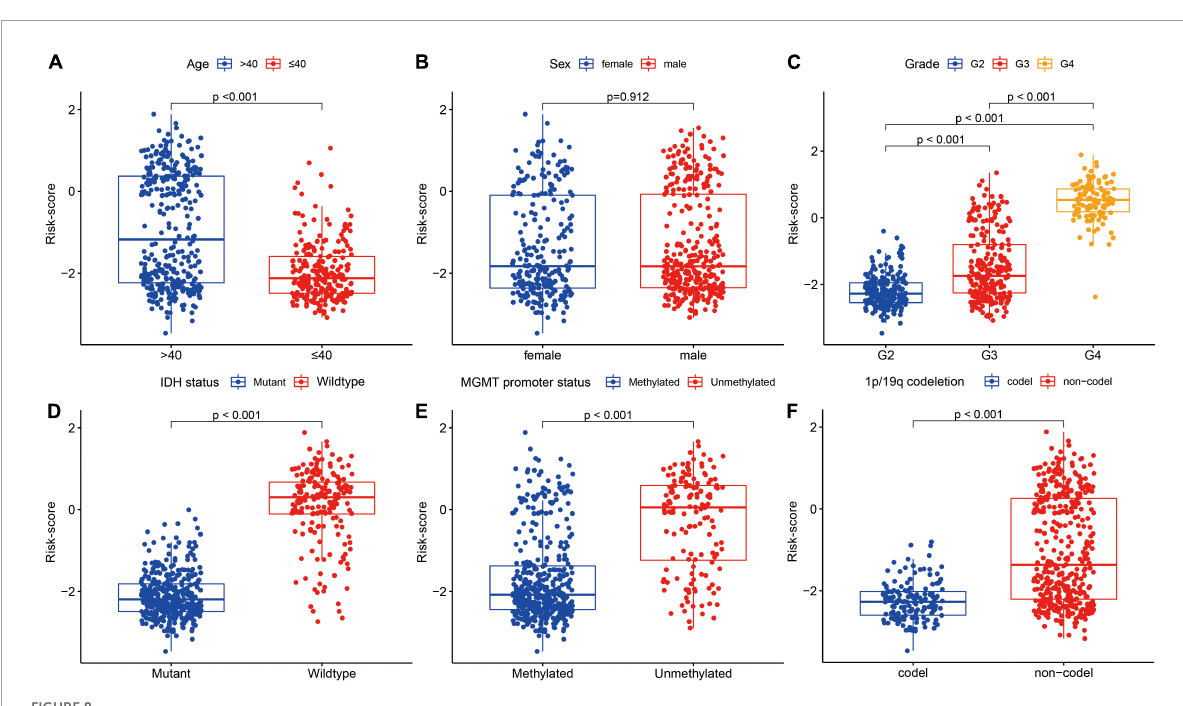
FIGURE8 Association between the FRGs and other clinicopathological characteristics ( A , age; B , sex; C , grade; D , IDH status; E , MGMT promoter status; and F , 1p/19q codeletion) in the training